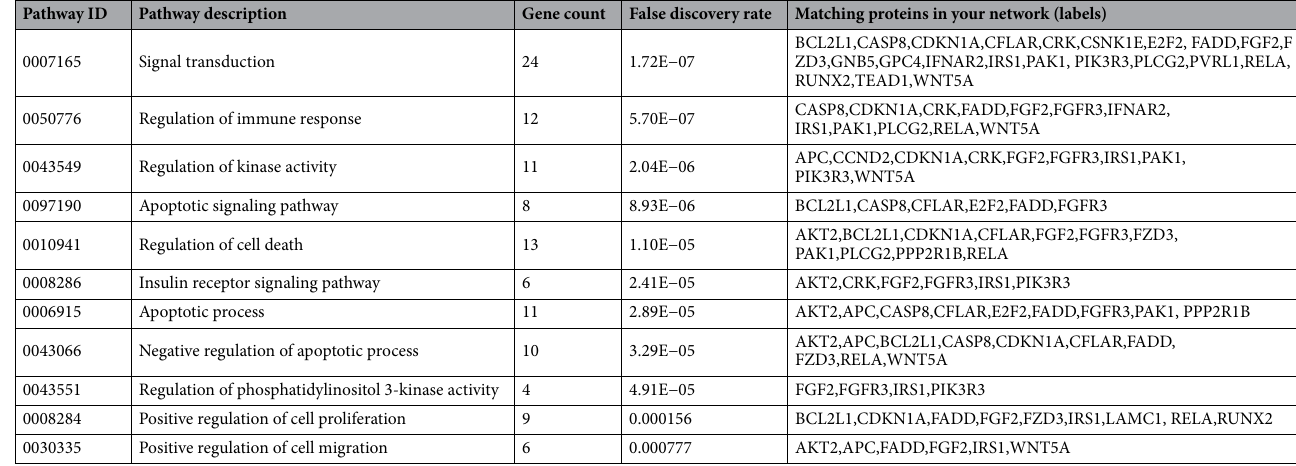
Table 5. GO pathways and matched member